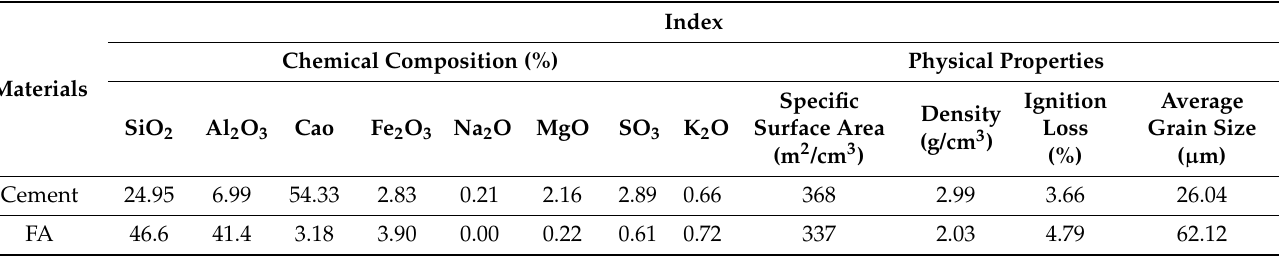
Table 2. Properties of cement and